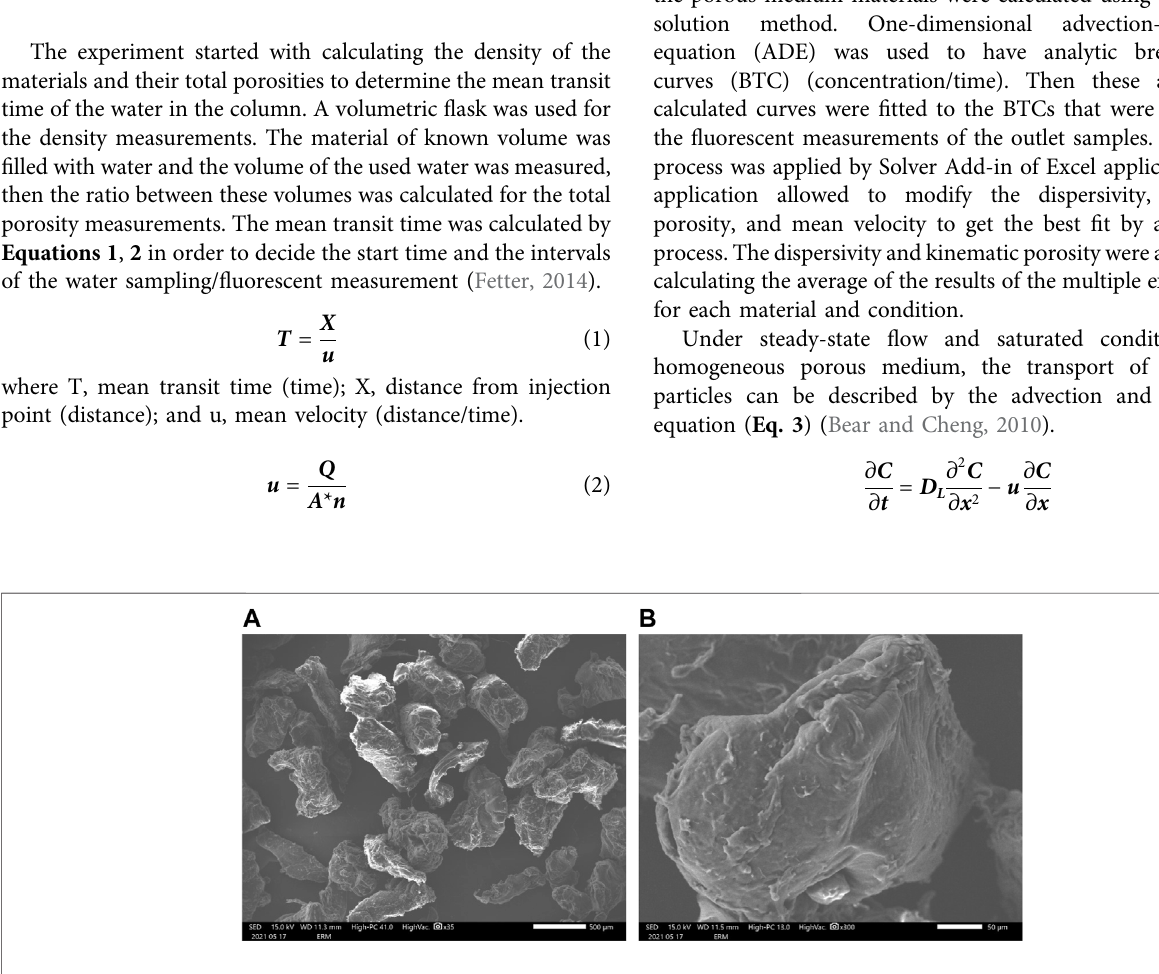
FIGURE 2 | SEM micrographs of the MP: (A) shape and size distribution; (B) detail of rugged PE particles.